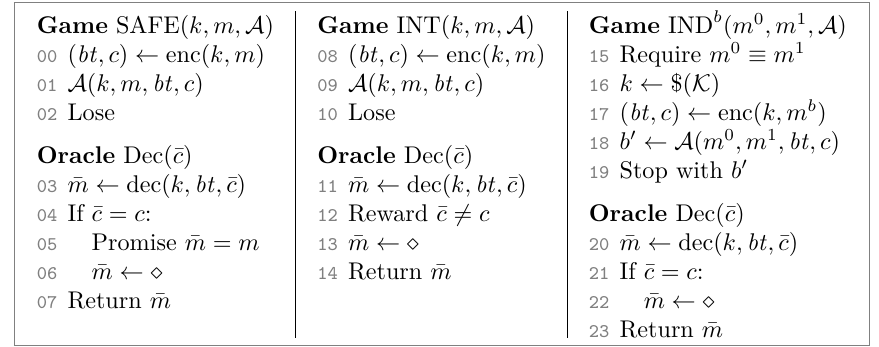
Figure 2: Games for encryptment. For the values ¯ c provided by the adversary we require that ¯ c ∈ C . Assuming (cid:5) / ∈ M , we encode suppressed messages with (cid:5) . We refer the reader to Appendix F.2 for a further